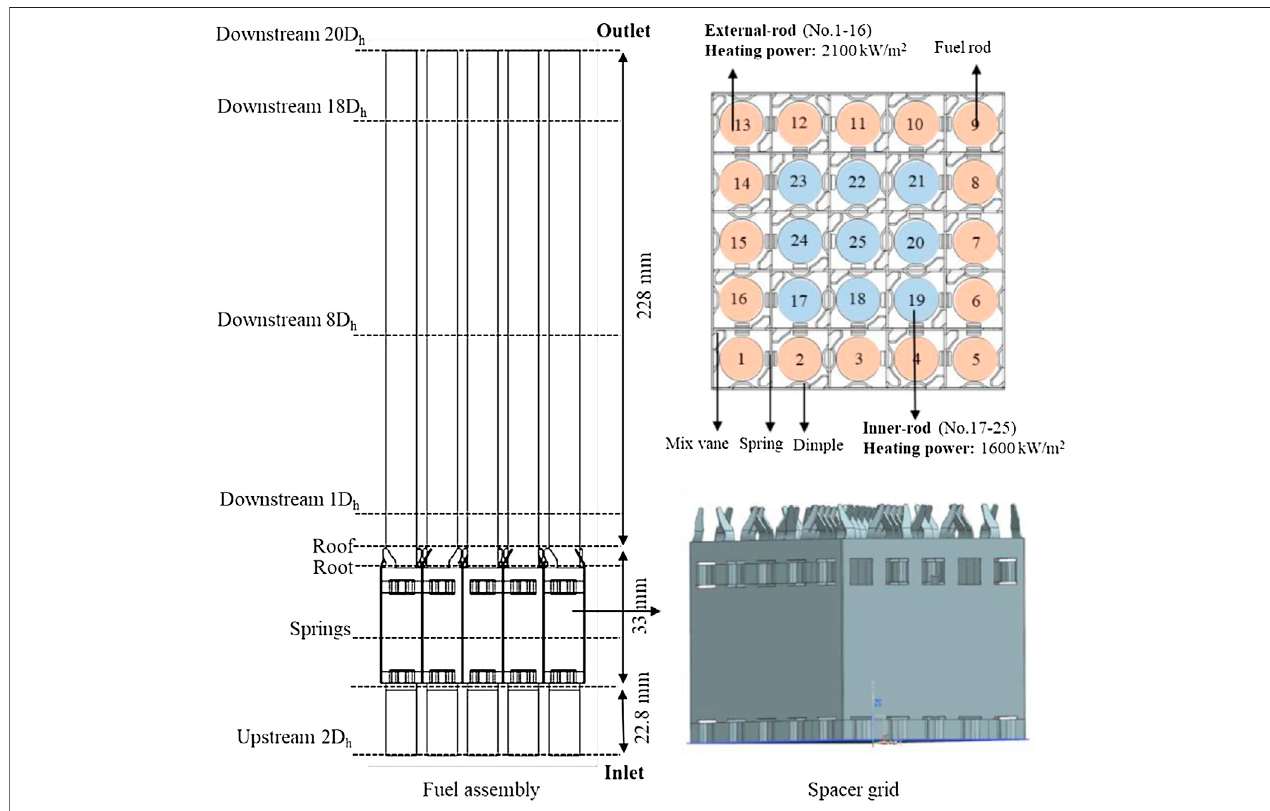
FIGURE 1 | Structure of the rod bundle with spacer grid and arrangement of the rods.